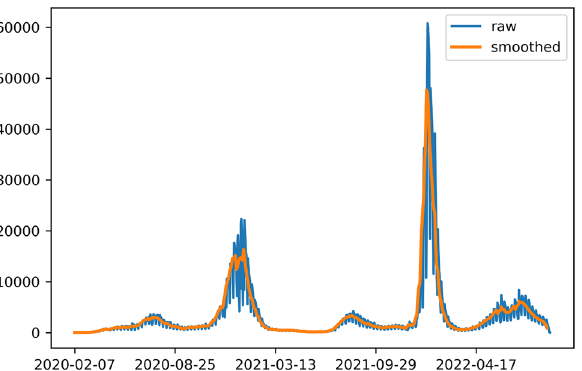
Figure 1. An example of visualizing daily observations, where blue line represents the data before smoothing, orange line represents data after smoothing. The data is collected from the Los Angeles